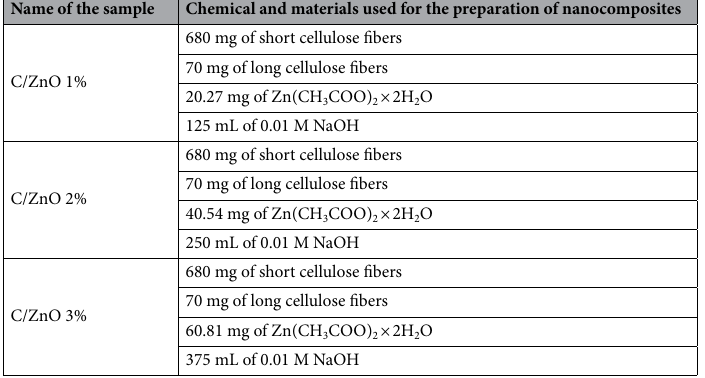
Table 1. Chemical and materials used for the preparation of